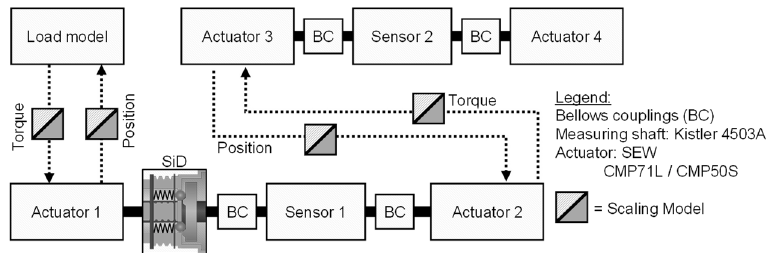
Figure 10. Investigation setup for the variant investigation of the overload clutch in scaled test bench investigations (schematic representation). Actuator 1 is torque controlled.